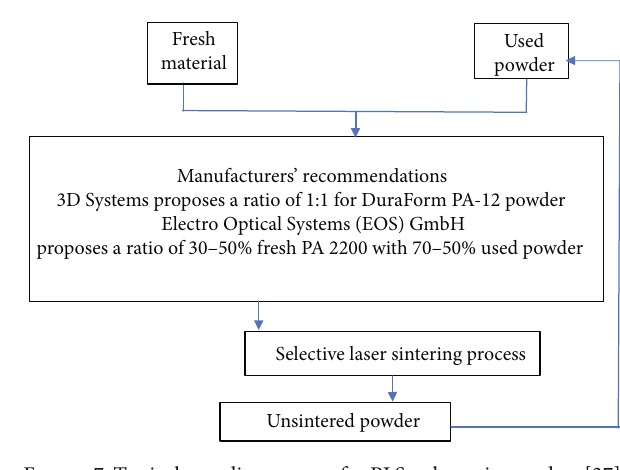
Figure 7: Typical recycling process for PLS polymeric powders